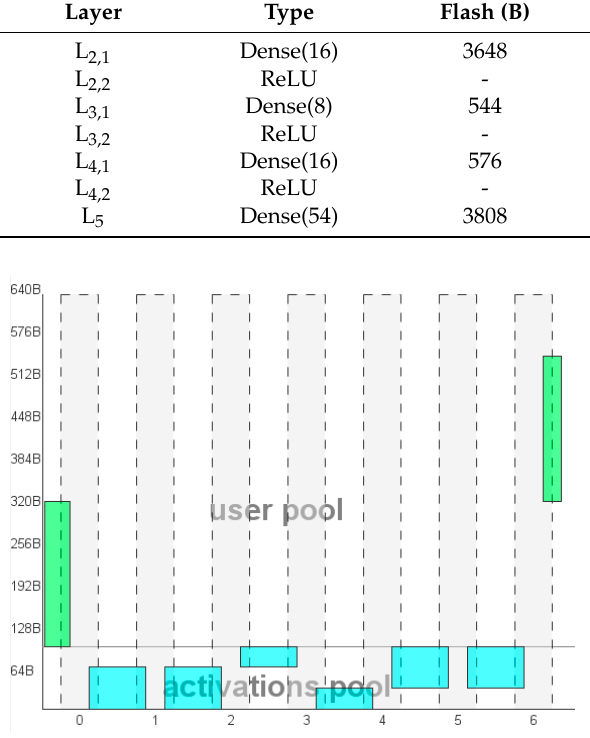
Figure 11. RAM and I/O memory usage of the autoencoder stage.